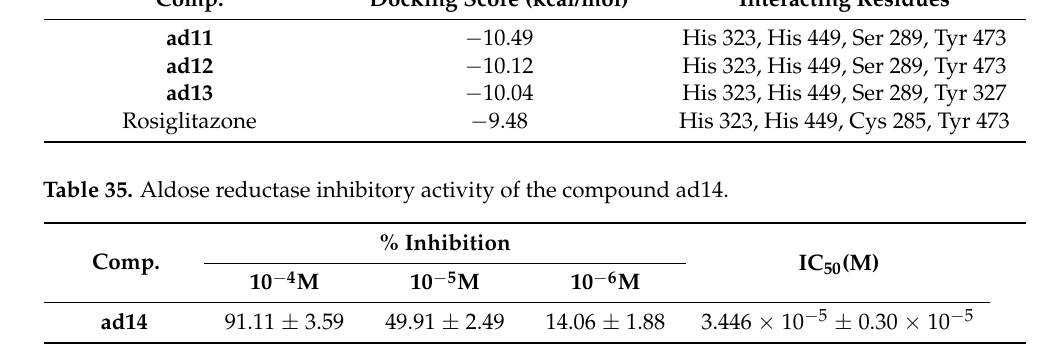
Table 34. Antidiabetic potential of the compounds ( ad11 – ad13 ) using molecular docking studies. Comp.